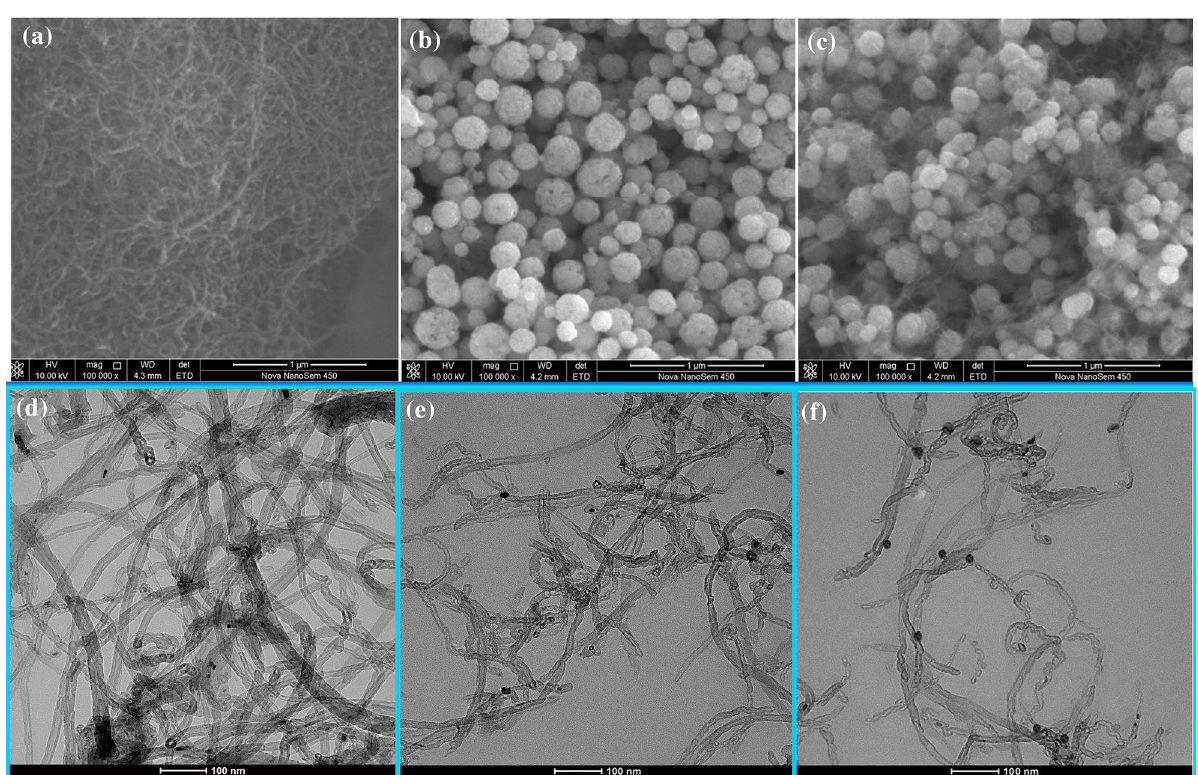
Figure 4. SEM images of 6O-MWCNTs ( a ), pure Fe 3 O 4 ( b ), and 6O-MWCNTs@Fe 3 O 4 ( c ) and TEM images of MWCNTs ( d ), 6O-MWCNTs ( e ), and 6O-MWCNTs@Fe 3 O 4 ( f